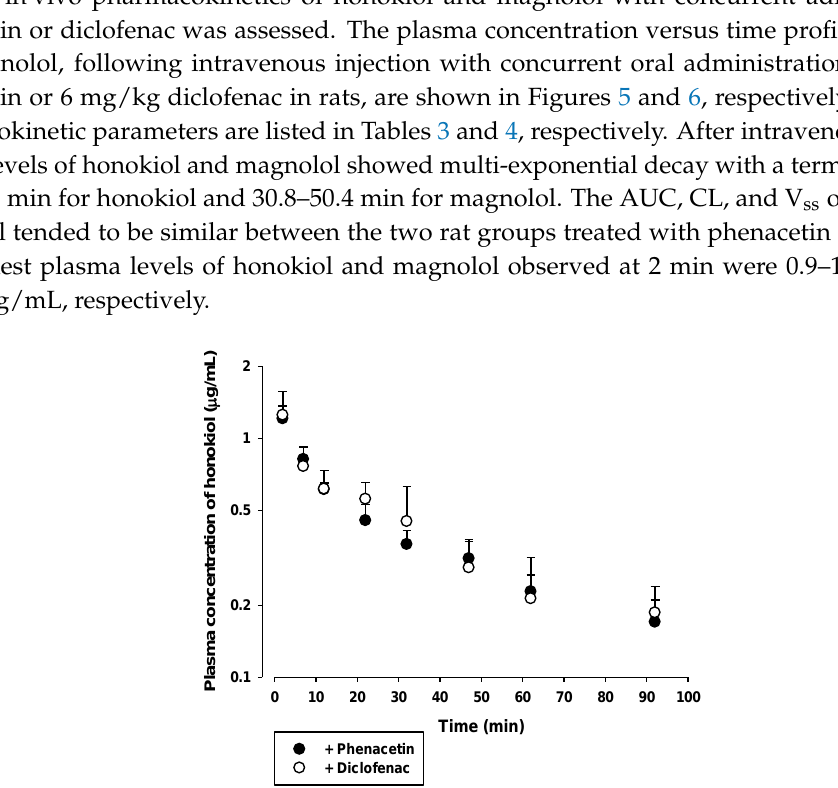
Figure 5. Plasma concentration versus time profiles of honokiol in rats following its intravenous injection at a dose of 5 mg/kg with concurrent administration of 20 mg/kg oral phenacetin (●) or 6 mg/kg diclofenac ( ○ ). The bullet symbols and their error bars represent the means and standard deviations, respectively ( n = 4). Table 3. Pharmacokinetic parameters of honokiol in rats following its intravenous injection at a dose of 5 mg/kg with 20 mg/kg oral phenacetin or 6 mg/kg diclofenac ( n = 4).